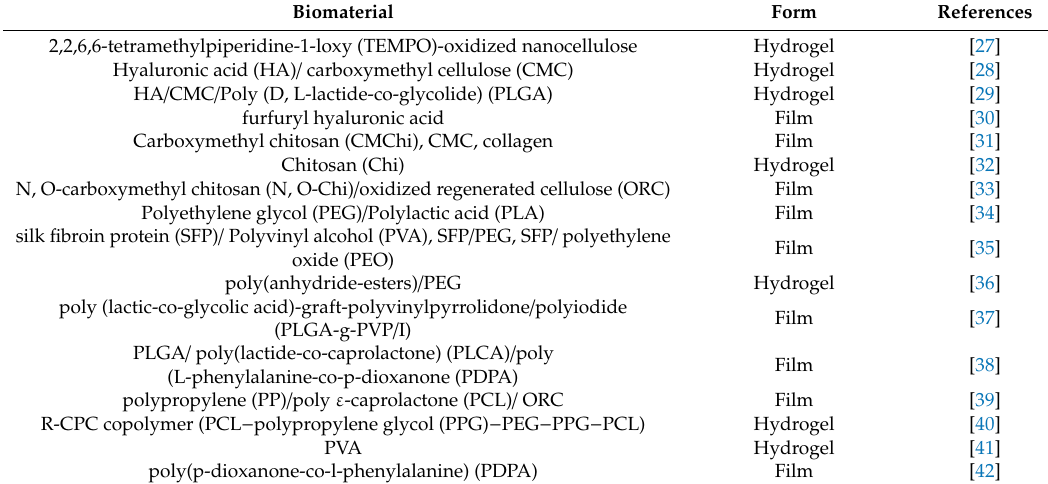
Table 1. Anti-adhesion barriers that have been the subject of recent research.